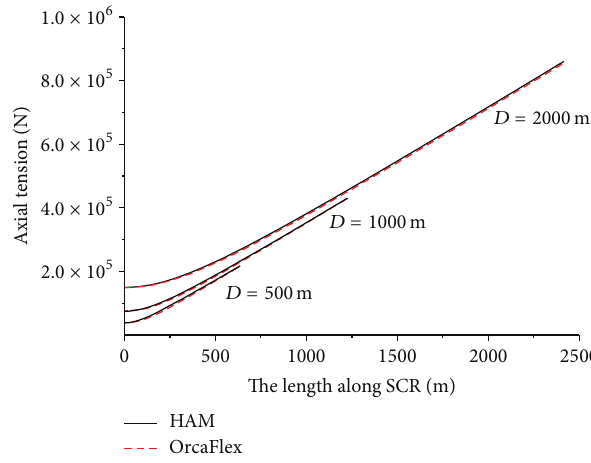
Figure 8: Axial tension results comparison between HAM and OrcaFlex in different water